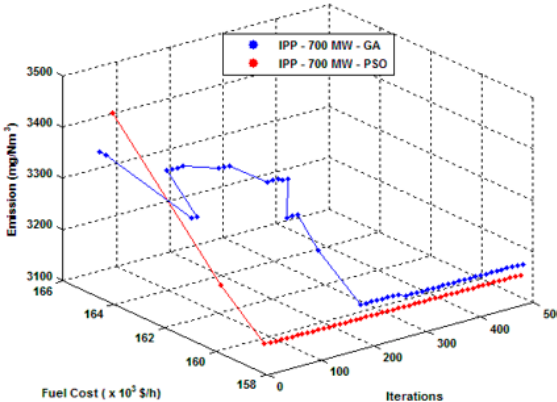
Figure 7. The convergence characteristics of PSO and GA with regard to fuel cost and emission for 28 Pakistani IPP with P D = 700 MW.